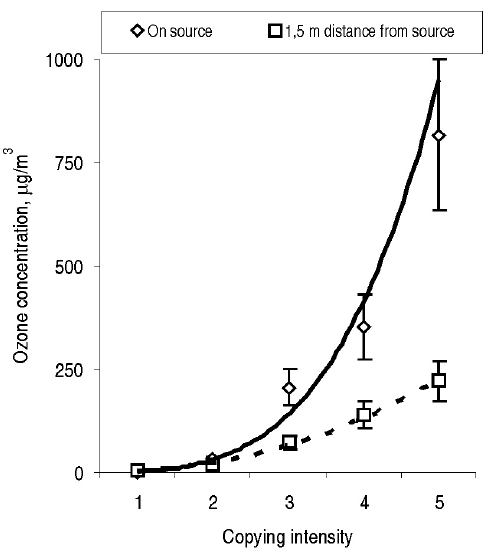
Fig 2. Change of ozone concentration with increase of copying